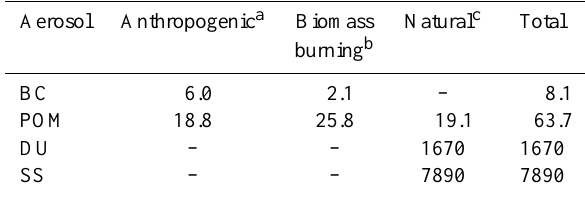
Table 2. Global aerosol emissions for the year 2005 in Tgyr − 1 . Aerosol Anthropogenic a Biomass Natural c